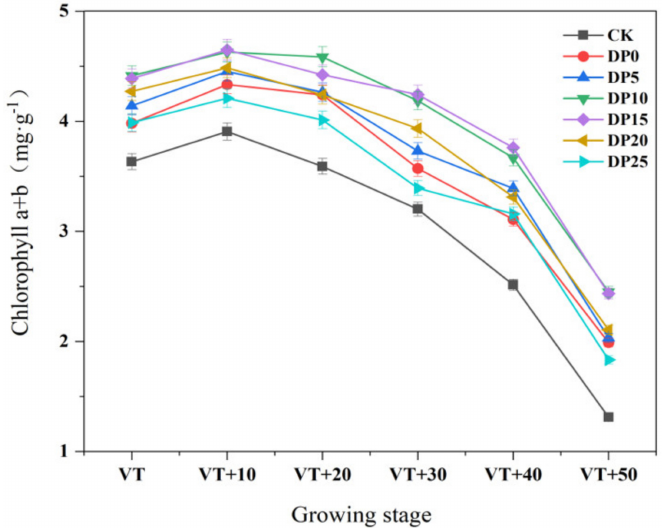
Figure 3. Effects of different basal application depths of controlled-release urea on chlorophyll a + b in leaves of panicle. CK: no fertilizer; DP0: surface application; DP5: fertilization depth 5 cm; DP10: fertilization depth 10 cm; DP15: fertilization depth 15 cm; DP20: fertilization depth 20 cm; DP25: fertilization depth 25 cm. Thin vertical bars are standard errors ( n =